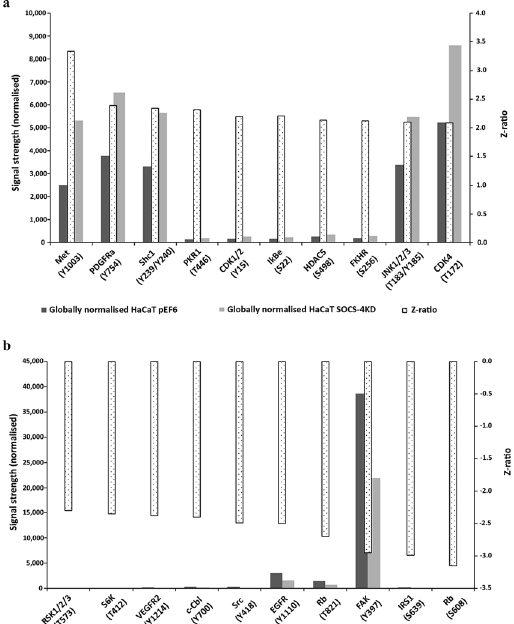
Figure 8. Impact of SOCS-4 suppression on HaCaT phosphorylation status. Summary of Kinexus protein microarray analysis highlighting the ten most highly upregulated ( a ) and down regulated ( b ) phospho proteins within HaCaT keratinocytes following SOCS-4 knockdown.[Met, met proto-oncogene; PDGFRa, platelet derived growth factor receptor alpha; shc1, SH2 domain-containing transforming protein 1; PKR1, Double- stranded RNA-dependent protein-serine kinase; CDK1/2, cyclin-dependent kinase 1/2; IkBe, NFKB inhibitor epsilon; HDAC5, Histone deacetylase 5; FKHR. Forkhead box protein O1; JNK1/2/3, c- Jun N-terminal kinase 1/2/3; CDK4, Cyclin-dependent protein-serine kinase 4; RSK1/2/3, Ribosomal S6 protein-serine kinase 1/2/3; S6K, Ribosomal protein S6 kinase beta-1; VEGFR2, Vascular endothelial growth factor receptor-tyrosine kinase 2; c-Cbl, Signal transduction protein CBL; Src, Src proto-oncogene-encoded protein-tyrosine kinase; EGFR, Epidermal growth factor receptor-tyrosine kinase; FAK, Focal adhesion kinase; IRS1, Insulin receptor substrate 1; Rb, Retinoblastoma-associated protein